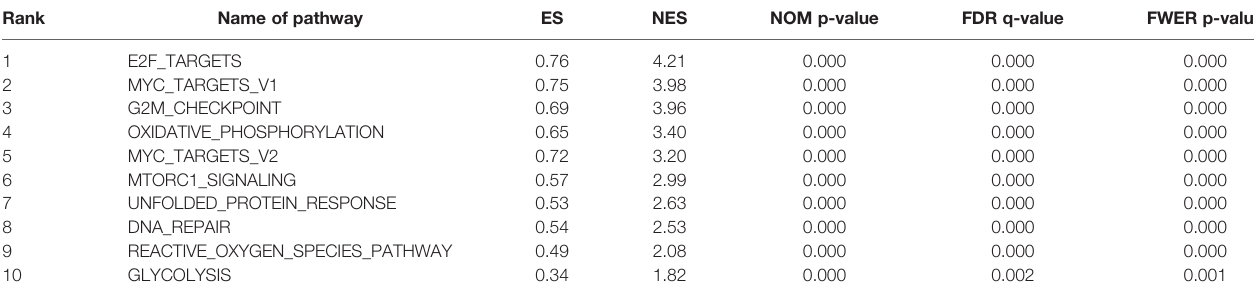
TABLE 5 | Top 10 biological processes enriched in lung adenocarcinoma based on heterogeneous nuclear ribonucleoprotein C (HNRNPC). Rank Name of pathway